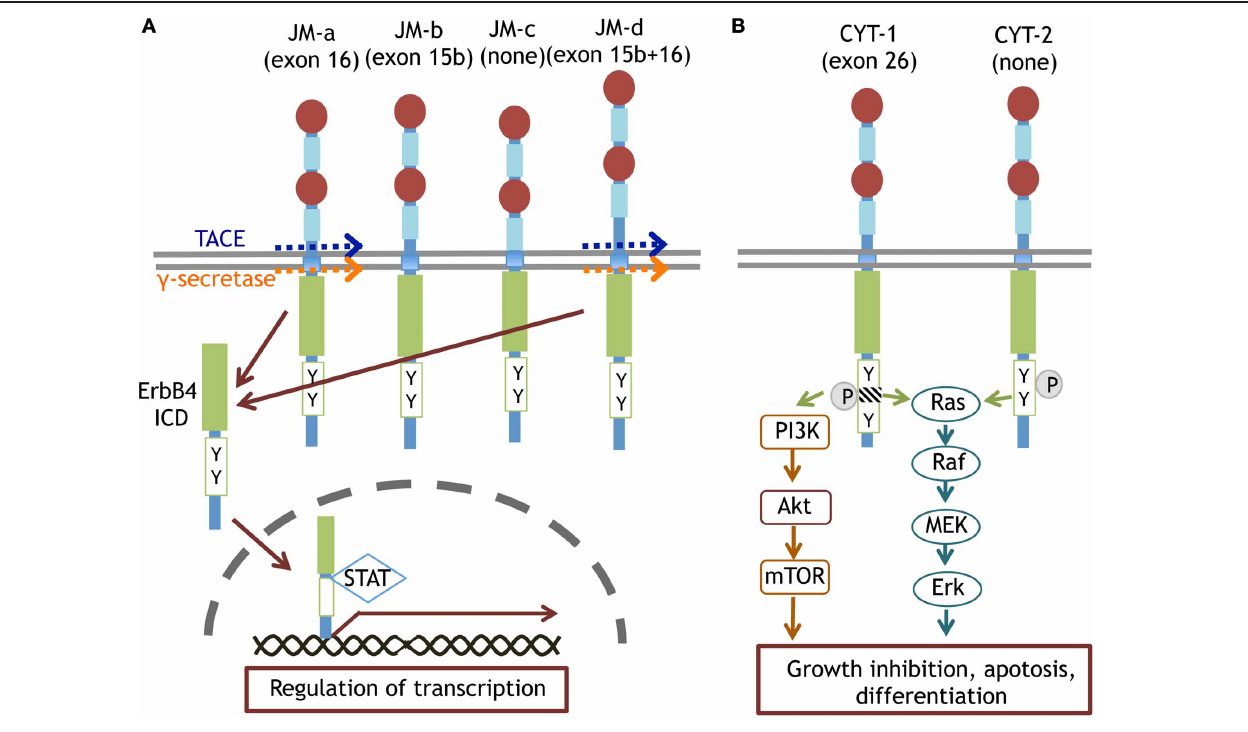
FIGURE 4 | Splice variants of ErbB4 proteins and their specific signaling. The JM-a and JM-d isoforms of ErbB4 are cleaved by TACE or γ -secretase and converted to ErbB4-ICD. ErbB4-ICD is translocated into